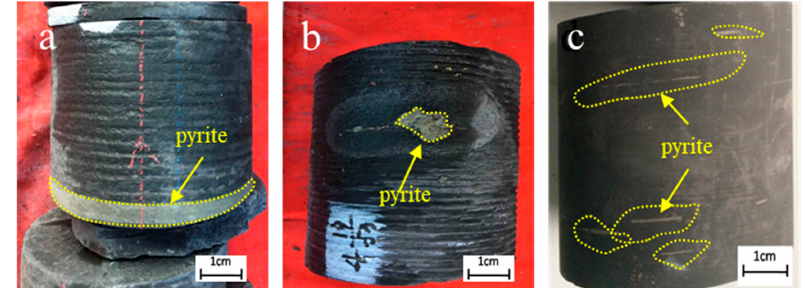
Figure 3. Core characteristics of the Longmaxi and Wufeng shales. ( a ) Stratiform pyrites in the gray silty shale of the Longmaxi formation, 921 m, well LY1; ( b ) separate nodular pyrites in the gray silty shale of the Longmaxi formation, 917 m, well LY1; ( c ) thin strips of pyrites in the Wufeng black shales, 1520 m, well YY2. Minerals 2018 , 8 , x FOR PEER REVIEW